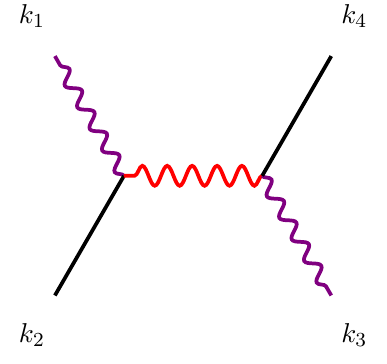
Figure 8 . psps amplitude due to exchange of a massive higher